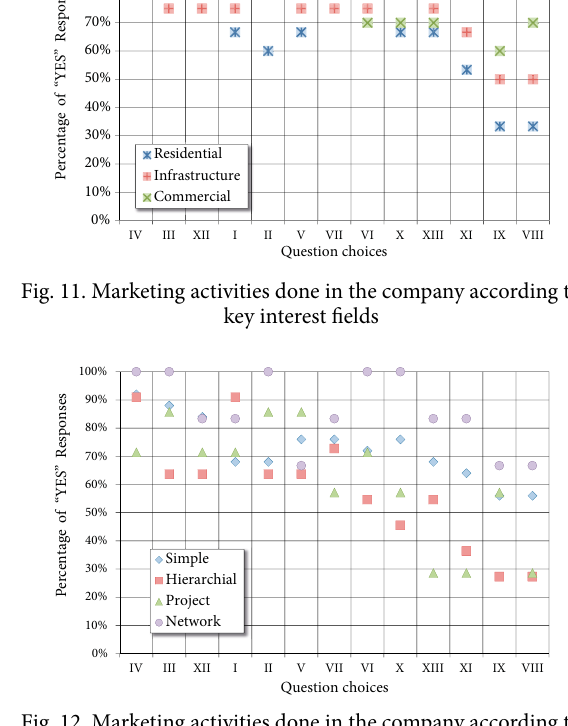
Fig. 12. Marketing activities done in the company according to organizational